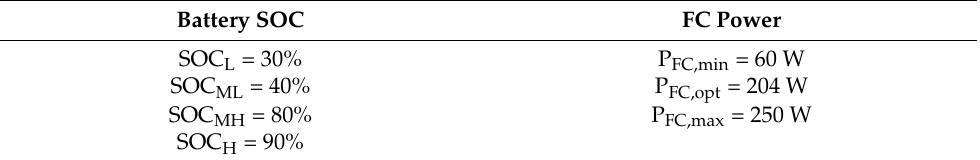
Table 3. Limits imposed on input and output parameters of the state machine